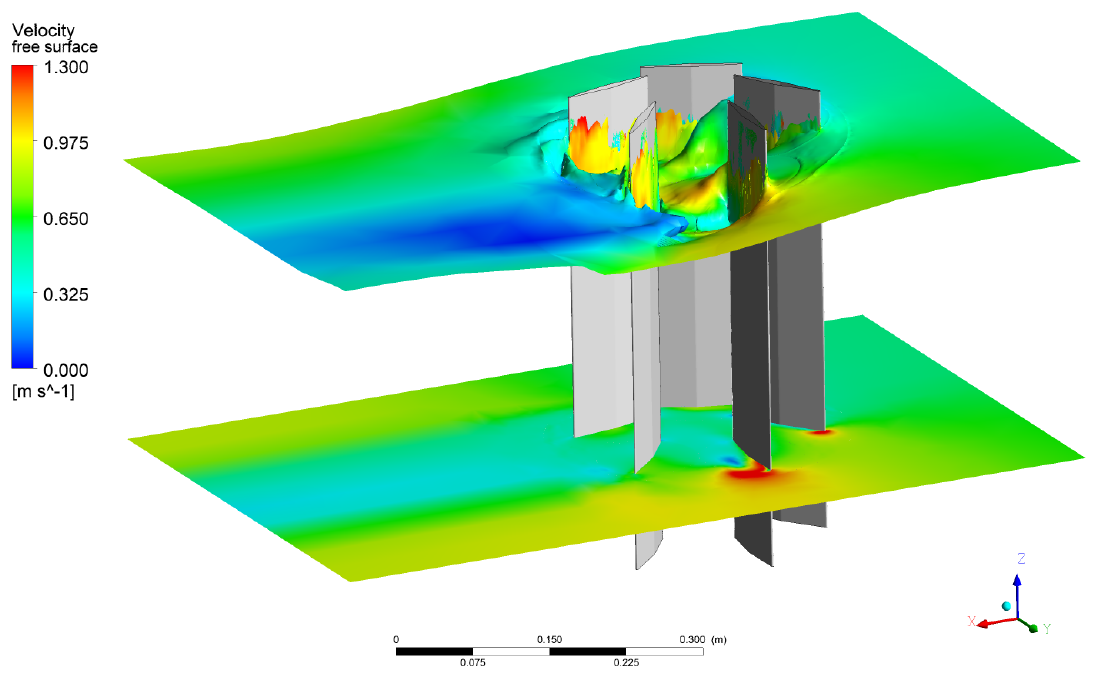
Figure 8. Qualitative flow velocity visualization on free surface